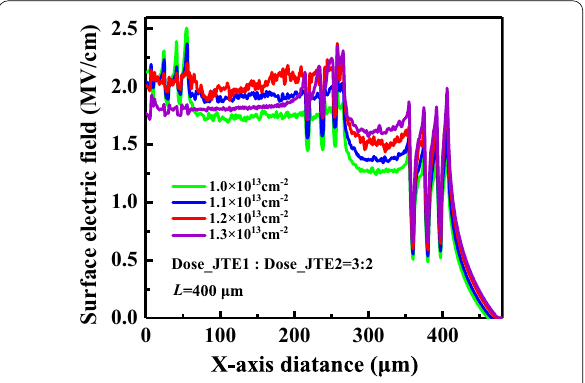
Fig. 4 Surface electric field distributions in breakdown corresponding to different implantation doses of JTE1